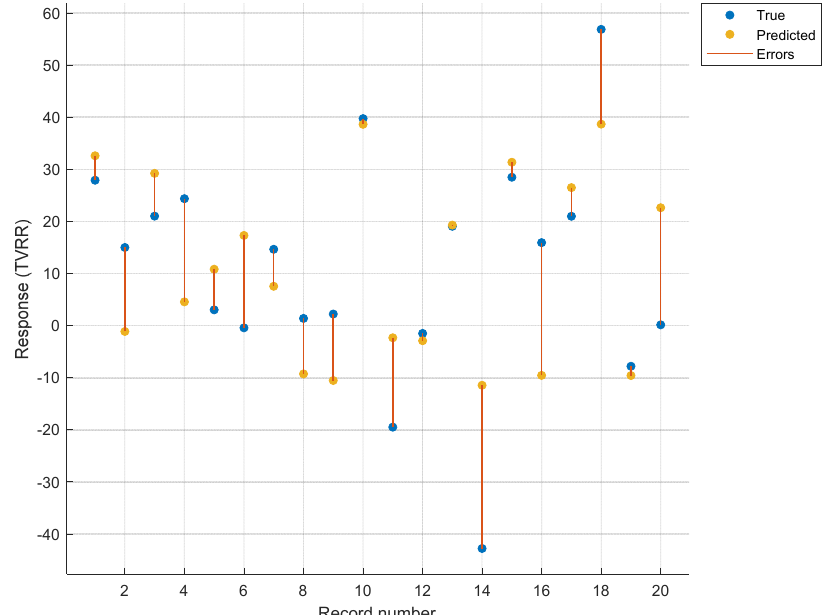
Figure 7. The predicted TVRR is plotted against the actual TVRR with individual differences shown in yellow.